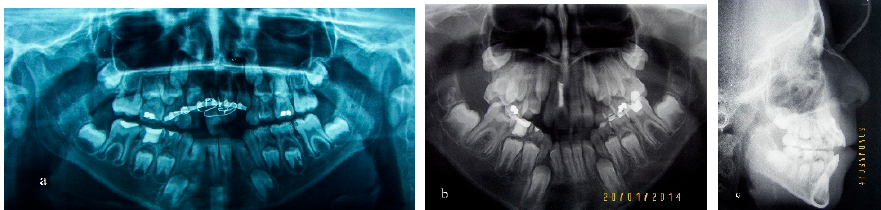
Figure 1. Radiographic examination. ( a ) Panoramic radiograph after repositioning and splinting, ( b ) panoramic radiograph after endodontic treatment, ( c ) lateral cephalogram before orthodontic treatment.